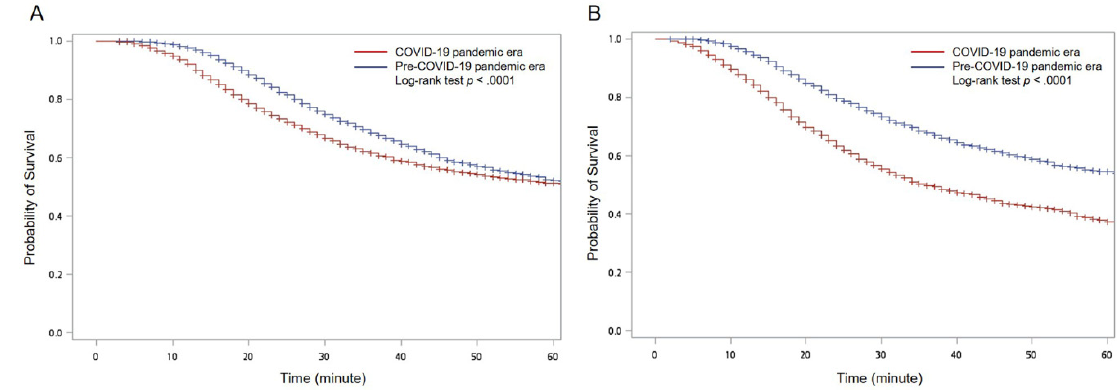
Figure 8. Kaplan–Meier curves with log-rank test for the time from emergency department (ED) arrival to brain computed tomography (CT) for traumatic brain injury (TBI)-related ED visits between the COVID-19 pandemic era and the pre- COVID-19 pandemic era during ( A ) P1 and ( B ) P2.